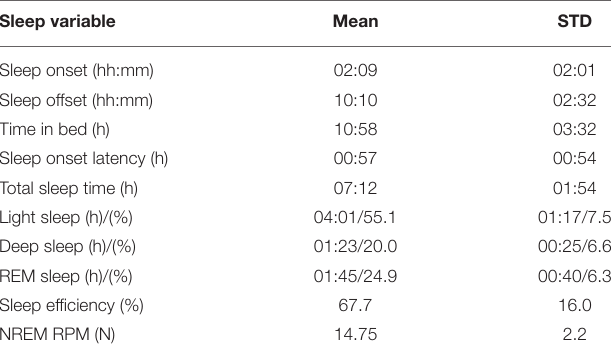
TABLE 4 | Descriptive statistics for the objective sleep patterns, based on 1243 nights of data in 27 esport players. Sleep variable